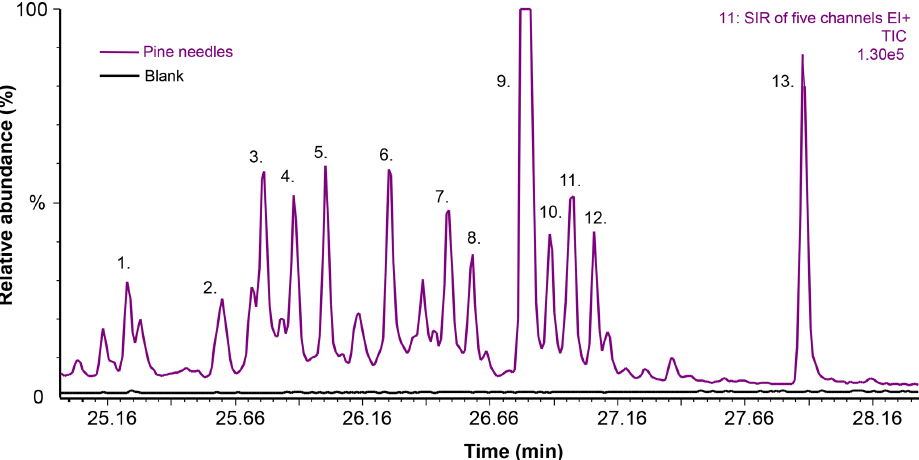
Figure 6. Selected ion recording (SIR) chromatograms from the TD–GC–MS1 analysis of pine needles and blank dynamic headspace sorbent tube samples (sampling at 60 ◦ C for 20min at a flow rate of 100mLmin − ). The five m/z ions included in the SIR were m/z 93, 229, 257, 272 and 275. The chromatogram is scaled for presentation purposes; peak number 9 is not shown in full height in order to visualise the other peaks more clearly. Peak identification is as follows. 1. Unknown (C 19 H 30 , BVOC). 2. Unknown (C 19 H 28 , BVOC). 3. Unknown (C 18 H 26 O, BVOC). 4. Unknown (C 19 − 20 H 32 O 0 − 2 , BVOC). 5. Unknown (C 20 H 32 , DT). 6. Sandaracopimaradiene (C 20 H 32 ,